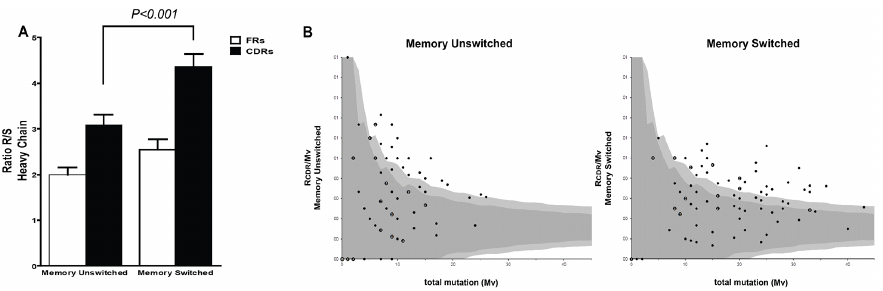
Fig. 4. Interference of antigen selection in memory B cells from SS patients. ( A ) Replacement:silent ratio (R/S ratios) were calculated for the complementary determining regions CDRs (black) and framework regions (white) for the heavy chain of both memory unswitched and switched B cells. A significant higher R/S ratio in the CDRs was observed in memory switched vs memory unswitched B cells. ( B ) The graphs show the ratio of replacement mutations in CDR1 and CDR2 (R CDR ) to the total number of mutations in V region (M V ) plotted against M V for the memory unswitched and switched B cells from SS patients. The dark and the light grey area indicate the 90% and 95% confidence limits for the probability of random mutations, respectively. A data point outside these areas represents a sequence that was antigen selected. The data were obtained using the Immunoglobulin Analysis Tool software